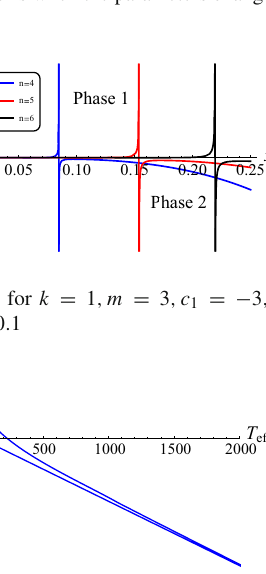
Fig. 4 P ef f − x diagrams when the parameters change respectively